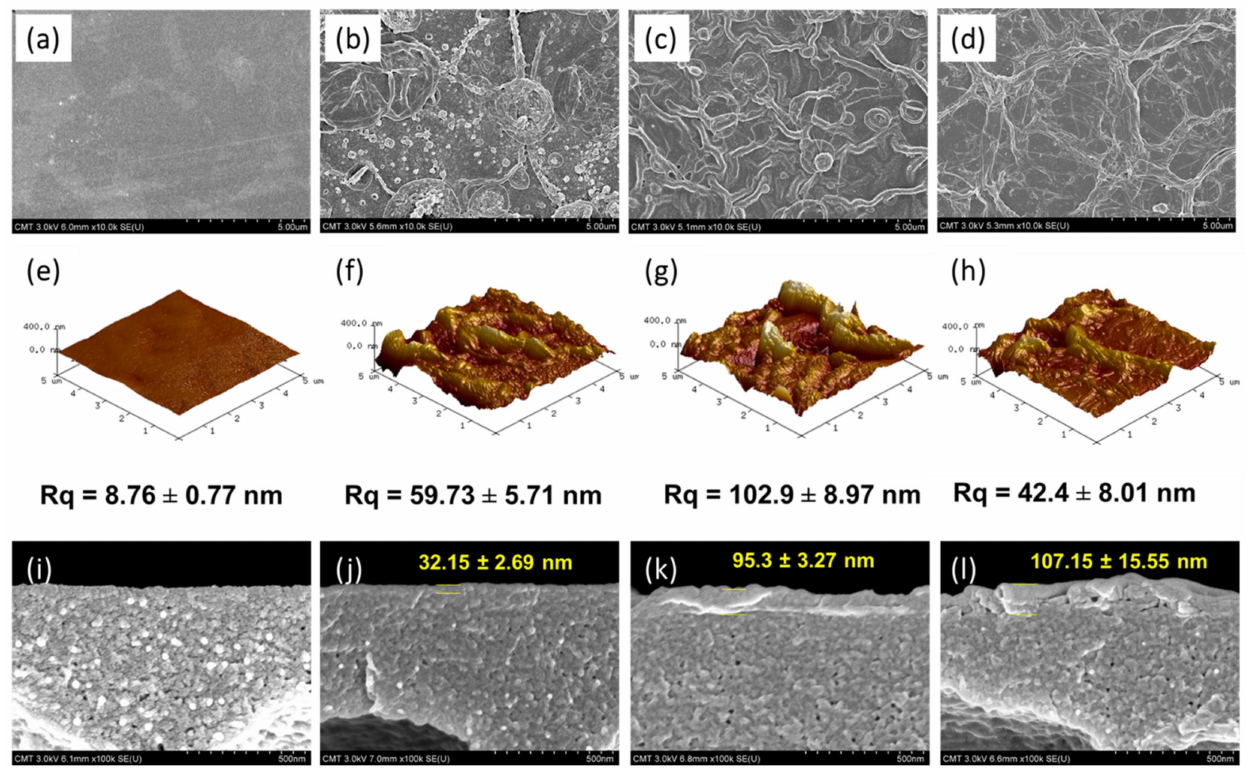
Figure 3. Surface and cross-sectional FESEM images, and surface roughness of ( a , e , i ) HPAN, ( b , f , j ) TFC CHD , ( c , g , k ) TFC EDA , and ( d , h , l ) TFC PPD